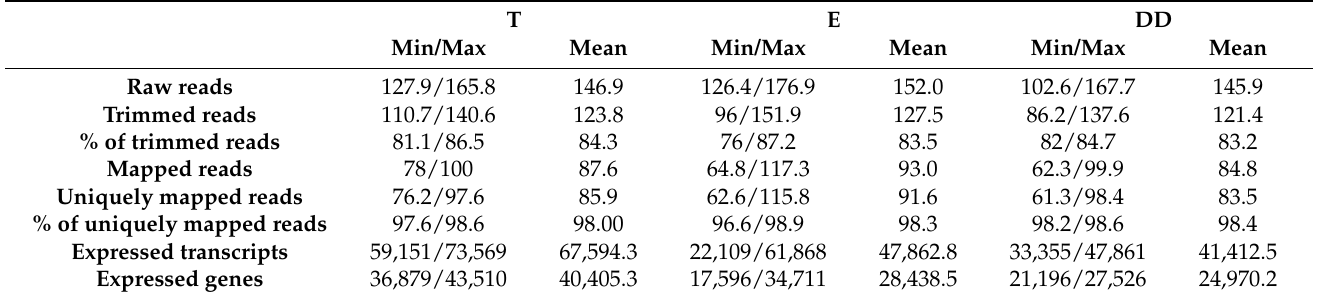
Table 1. Overall statistics of sequenced, mapped and processed data. The read values are presented in millions. Min/max are the minimum and maximum values. Mean values are calculated for all six samples for each